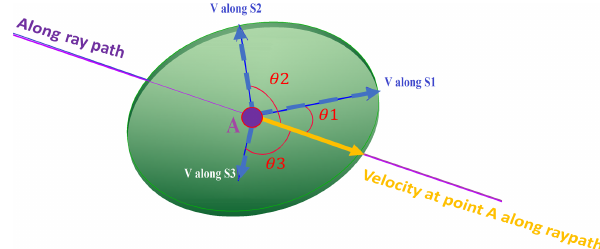
Figure 10. The ellipsoidal model used to approximate the veloc- ity of each point along the ray path by combining the calculated stress field and the velocity data from the true-triaxial experiments (Nasseri Behrestaghi et al.,